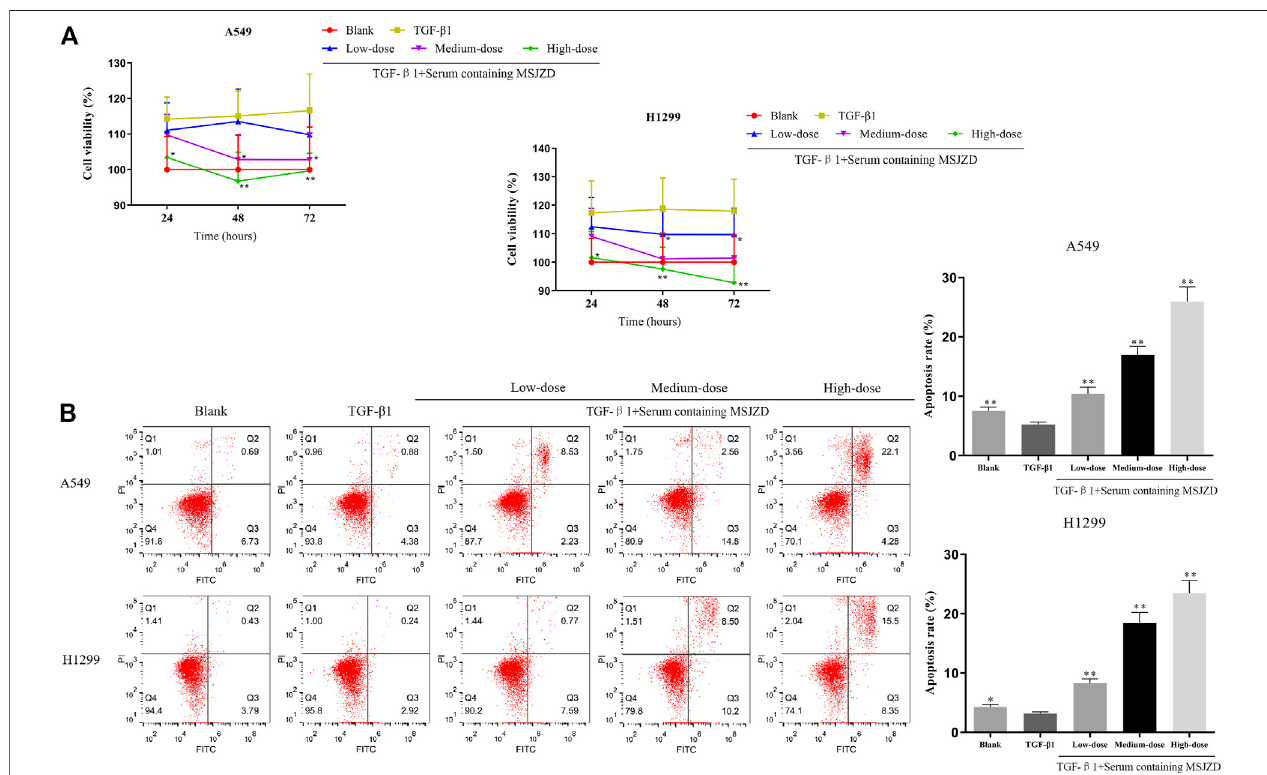
FIGURE 3 | Serum-containing MSJZD weakened the cell viability and augmented apoptosis in NSCLC cells induced by TGF- β 1. (A) Cell counting kit-8 (CCK-8) assaywasperformedinTGF- β 1-inducedA549andH1299cellstreatedwithserum-containingMSJZD. (B) TheA549andH1299cellsweretreatedwithblankcontrolor serum-containing MSJZD and analyzed by fl ow cytometer to indicate cell apoptosis. * p < 0.05, ** p < 0.01 vs. the TGF- β